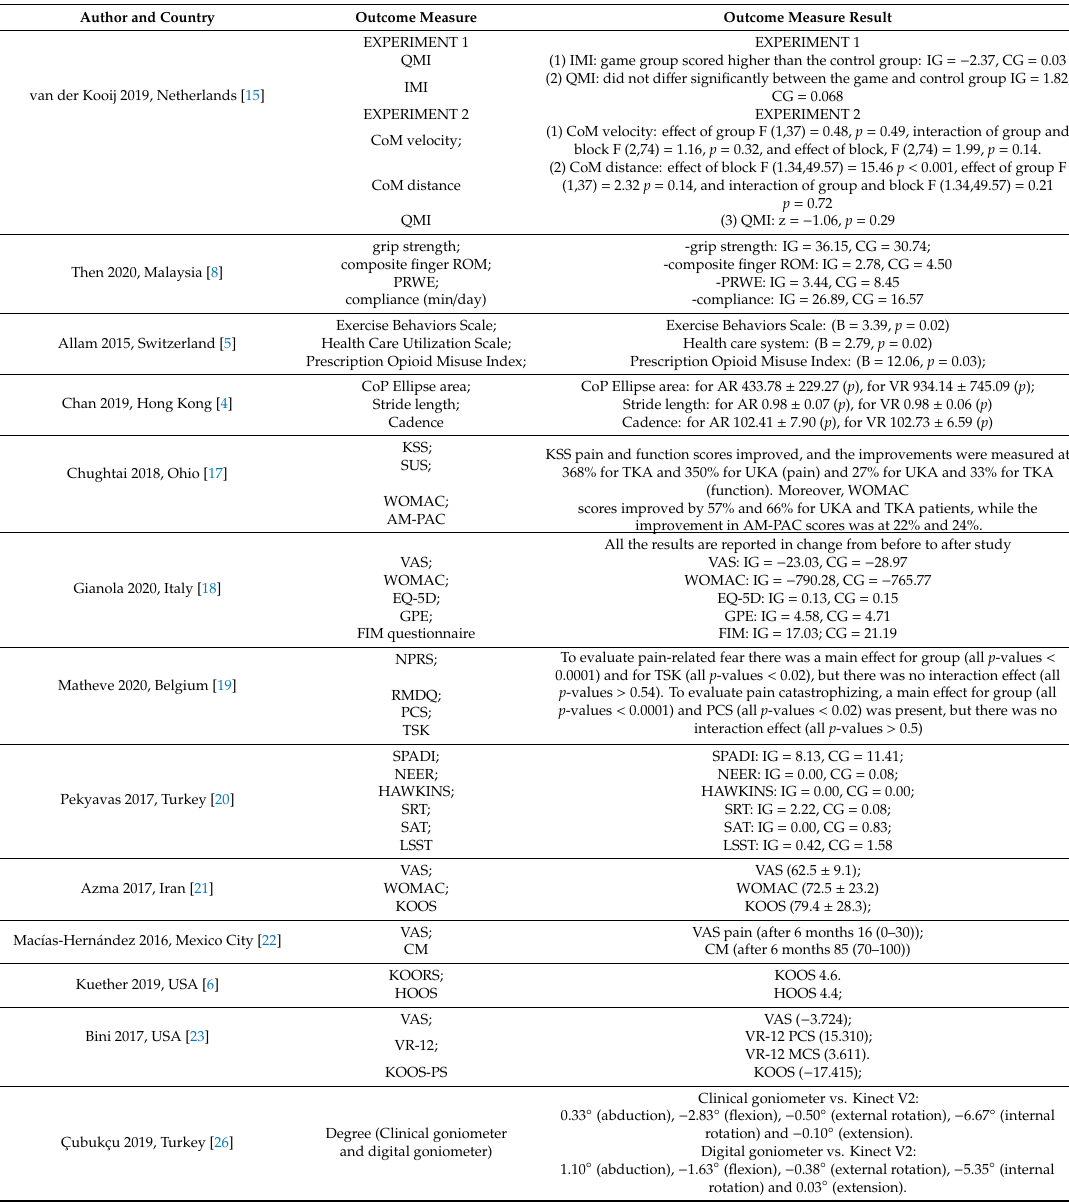
Table 5. Quantitative